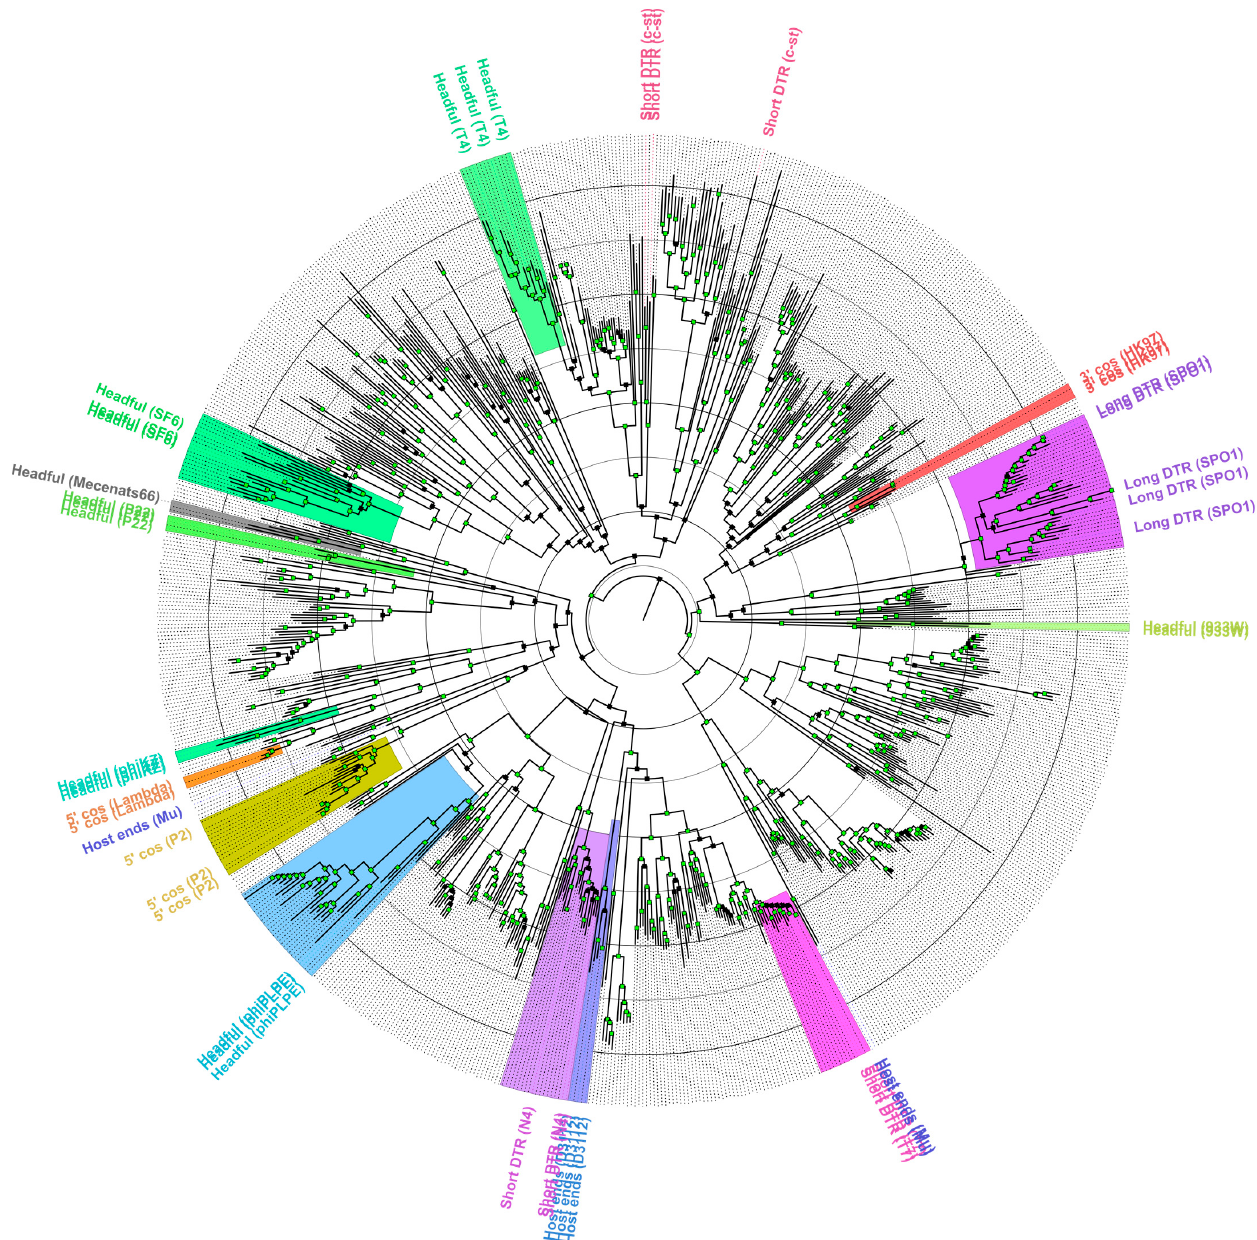
Figure 7. The maximum-likelihood tree of representative terminase/terminase large subunit (TerL) amino acid sequence diversity. Input alignment had 793 sequences with 6470 columns, 4725 distinct patterns, 3011 parsimony-informative, 1119 singleton sites, and 2340 constant sites. The tree was built using Blosum62 + R10 as the best-fit substitution model. Near zero-length branches were collapsed into polytomies. The tree shown is midpoint rooted. Tip labels are provided for phages that had their packaging strategy/genome termini type verified experimentally and are colored based on the distinct packaging strategies phages within the presumed same packaging strategy clades employ (sequences from the extended “core” dataset have their respective packaging strategies indicated at the corresponding tips [34]; Figure 4) The clade consisting of the terminase sequence from Mecenats66, Dolphis, and PHB04 is highlighted in grey. LDTR stands for long direct terminal repeats, SDTR for short direct terminal repeats. Distal nodes of branches having UFBoot support higher or equal to 95% are indicated by green squares. The tree is drawn to scale, branch lengths represent the number of amino acid substitutions per site, and the radial circles are spaced 0.5 amino acid substitutions per site